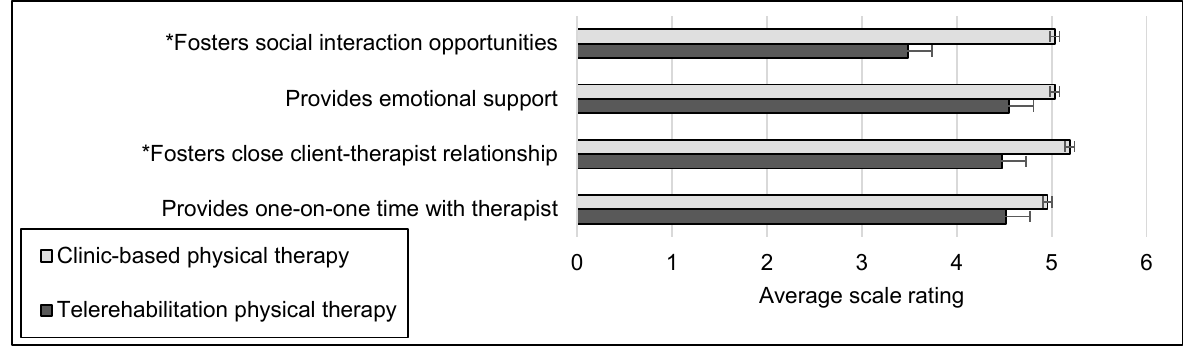
Average Likert-type Scale Ratings Concerning Therapist-Client Interactions and Relationships